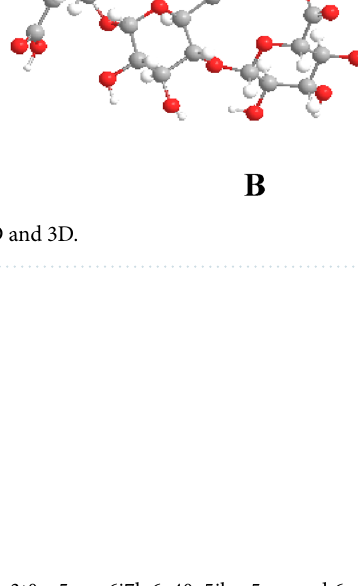
Table 3. Interaction of the receptors of the PDBs (1e3g, 3t0c, 5czz, 6j7l, 6v40, 5ibs, 5zsy and 6ggb) with the